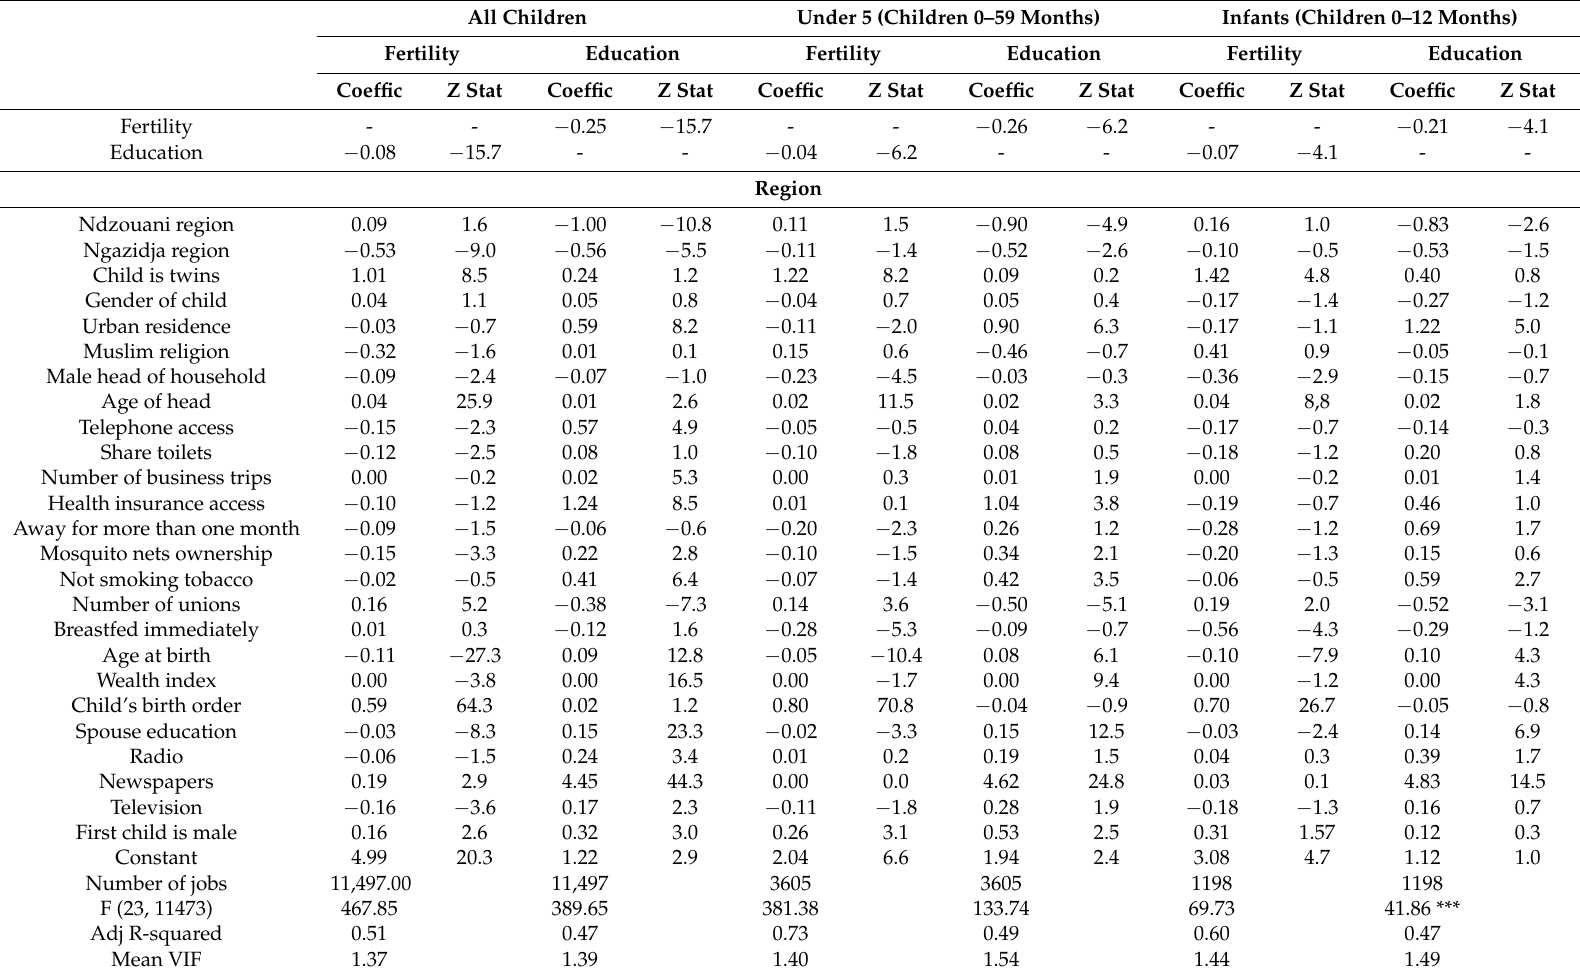
Table 3. Determinants of Maternal Fertility and Years of Education using Ordinary Least Square (OLS) regression. All